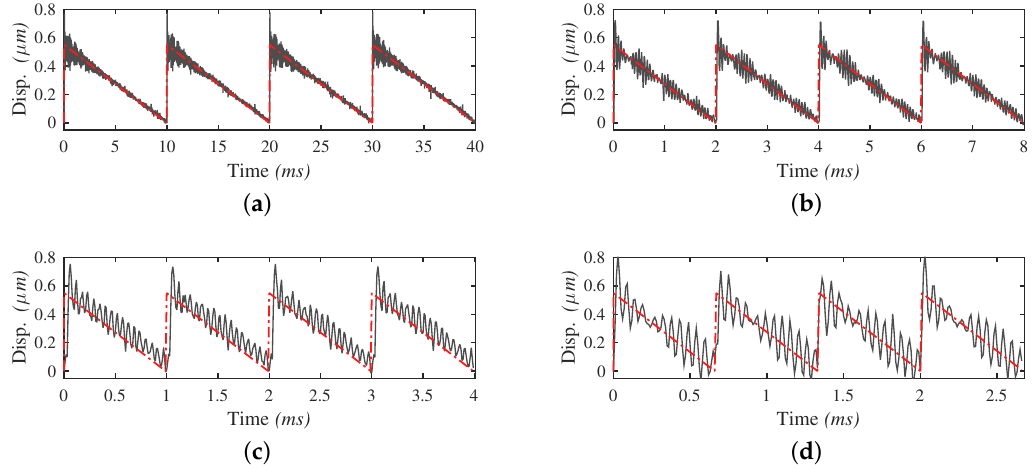
Figure 8. Input displacements with STW signals in different driving frequencies. The grey curves represent the actual input displacement of the pusher, and the red curves represent the ideal input displacement driven by STW signals. Due to the residual vibration, the displacement is flipped for better visualization. The frequencies of the signals are: ( a ) 100 Hz; ( b ) 500 Hz; ( c ) 1000 Hz; ( d ) 1500